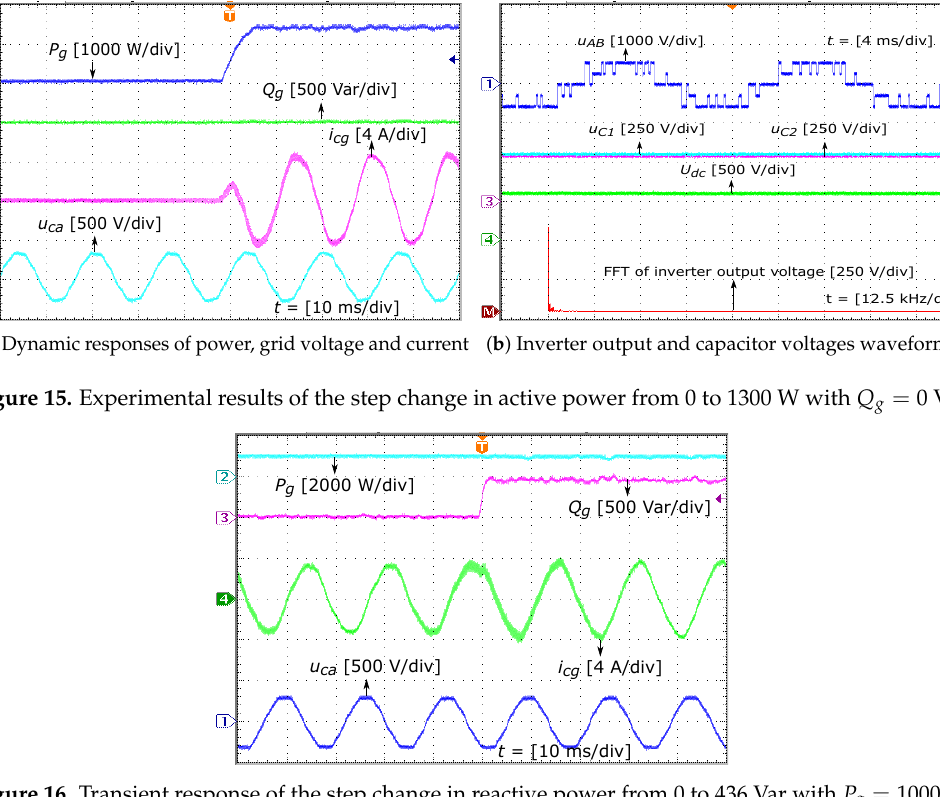
Figure 16. Transient response of the step change in reactive power from 0 to 436 Var with P g = 1000 W. Two controllers had the same performance of the THD for the grid current, as depicted in Figure